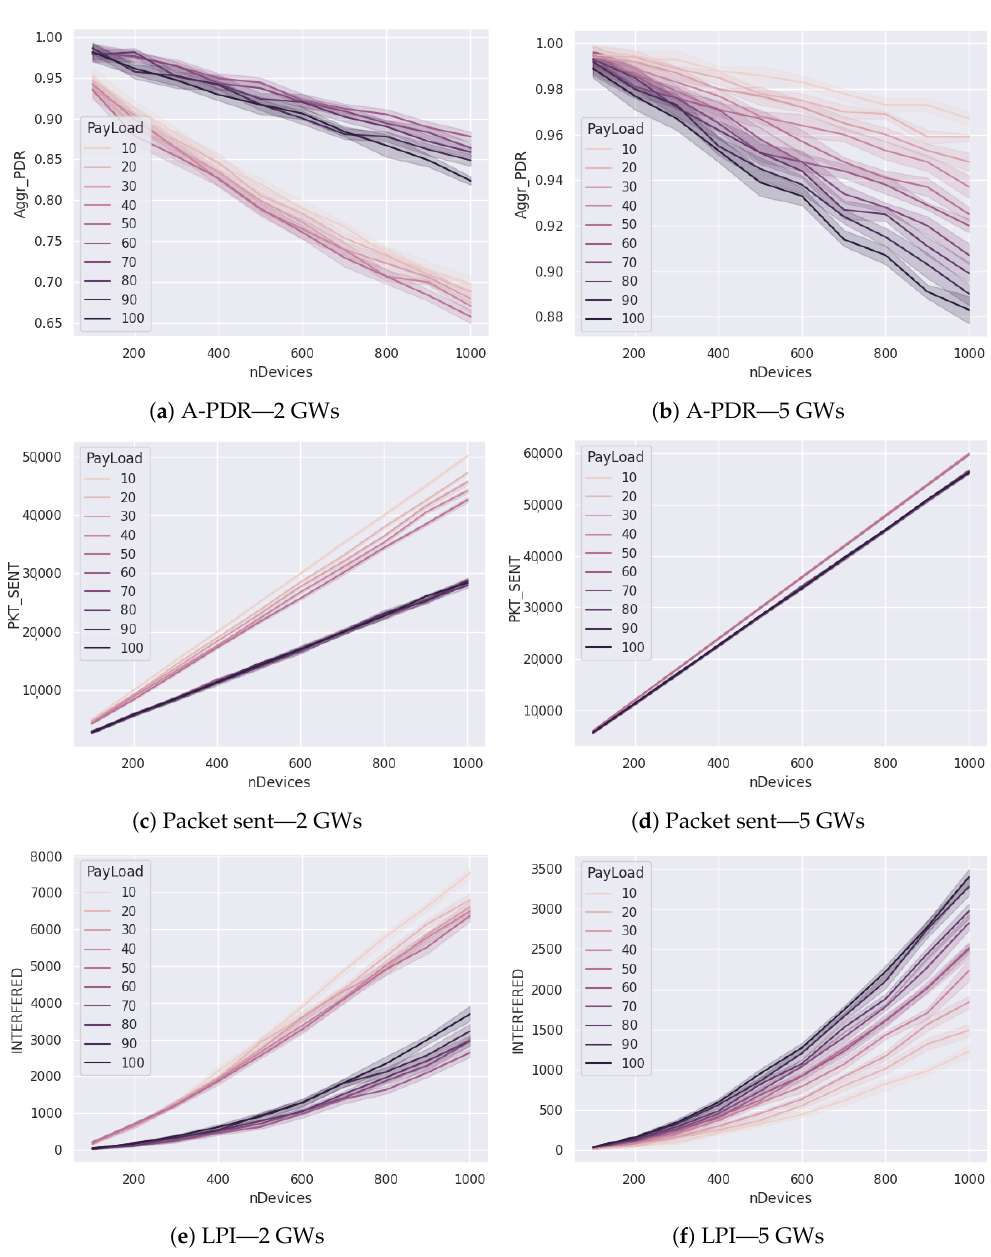
Figure 3. Performance results for two and five gateways while varying the payload length with a frequency of 1 packet/min—unconfirmed traffic. Table 4. Airtime and number of allowed messages according to different data rates for a payload of 10 bytes